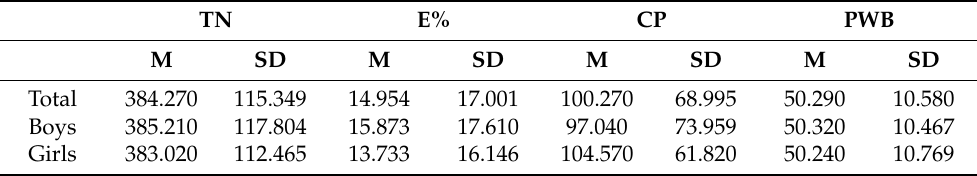
Table 2. Descriptive statistics of cognitive function and PWB by gender and total